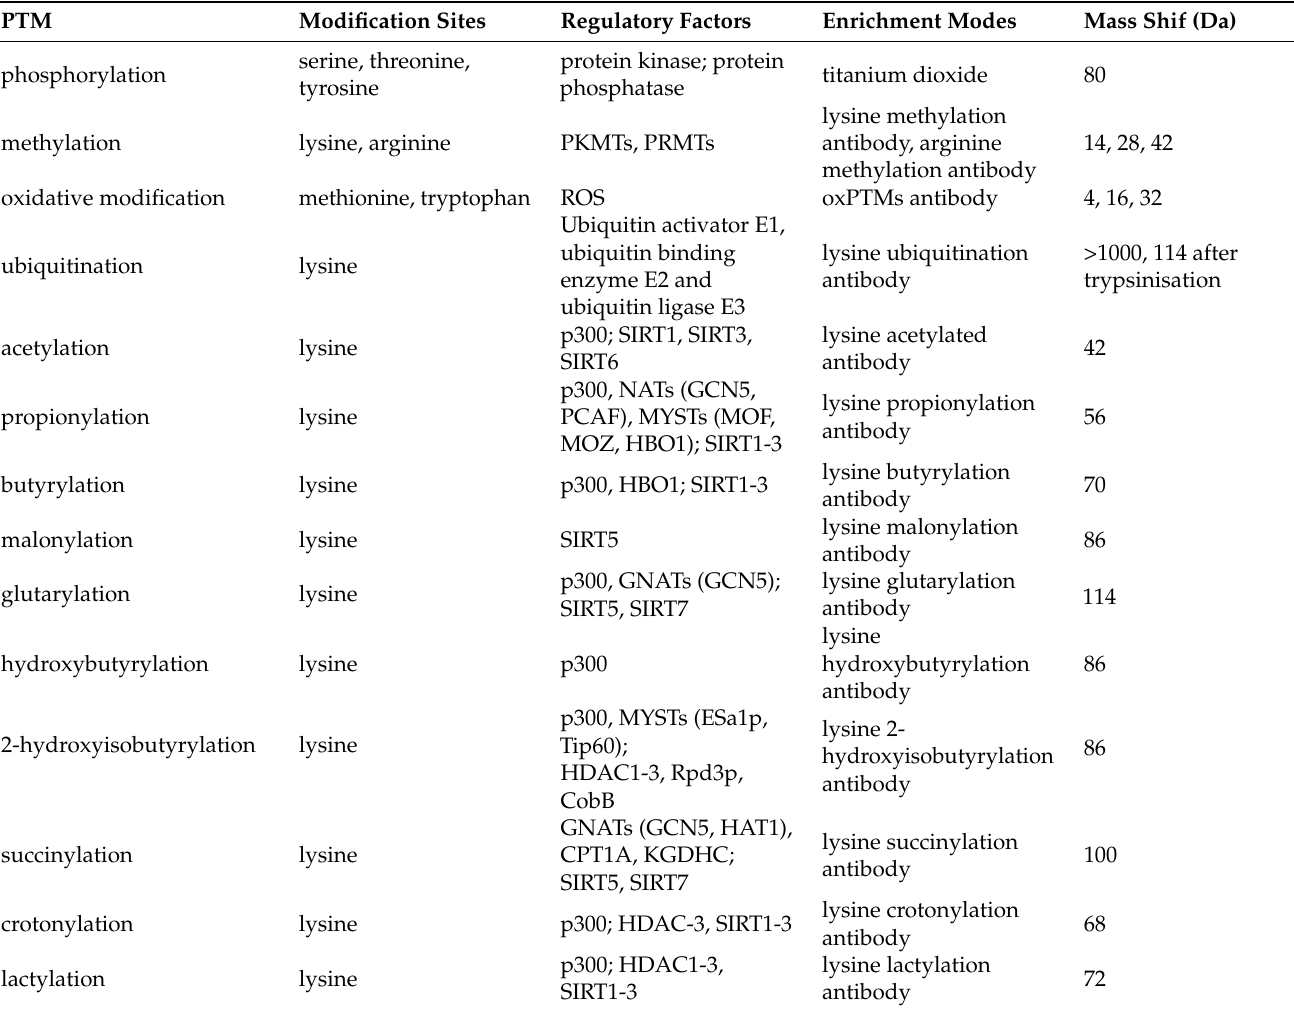
Table 1. Summary of common posttranslational modification types, modification sites, regulatory factors, enrichment modes, and mass shifts in mass